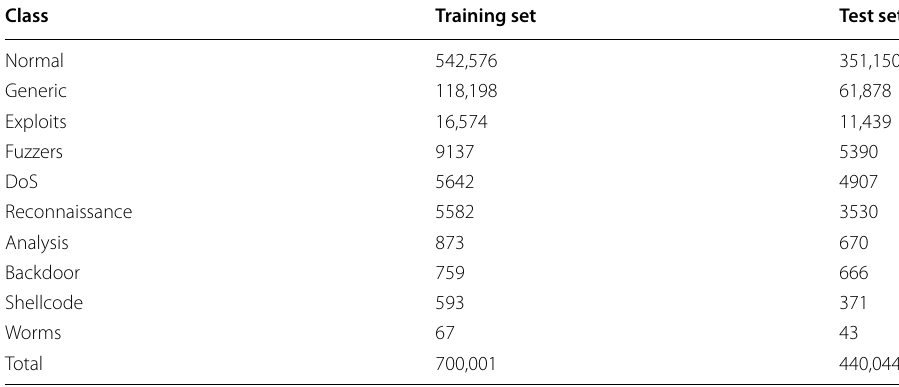
Table 4 Information about the samples of UNSW-NB15 Class Training set